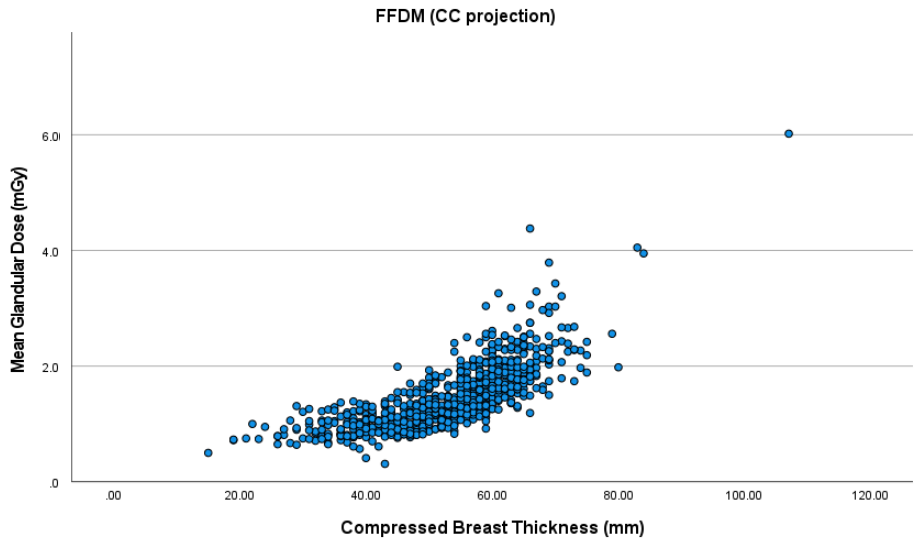
Figure 1. Mean glandular dose (MGD) in full-field digital mammography (FFDM) in the craniocaudal (CC)